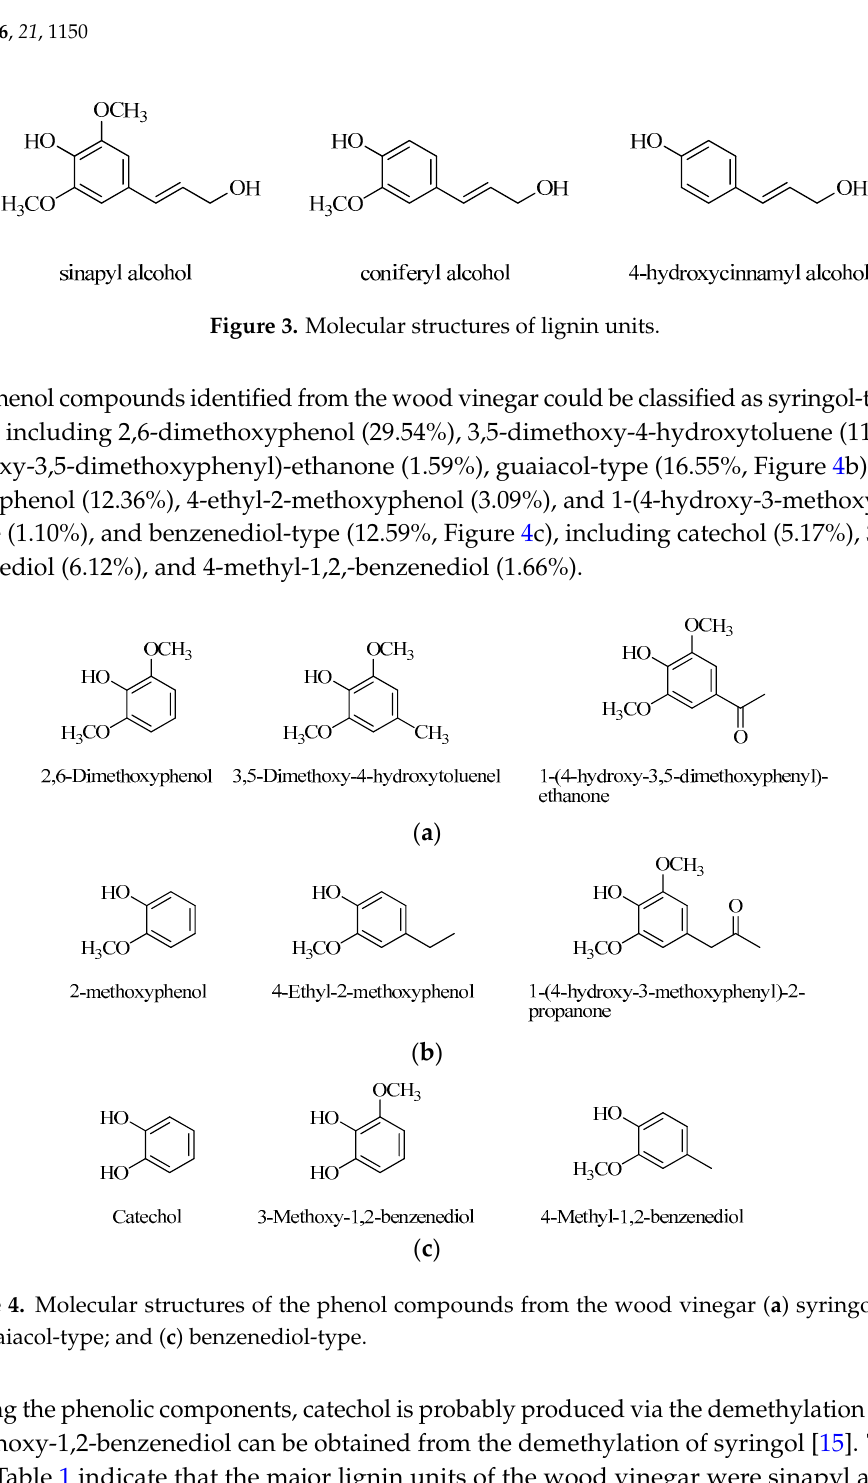
Table 2. Antibacterial activity of the wood vinegar.